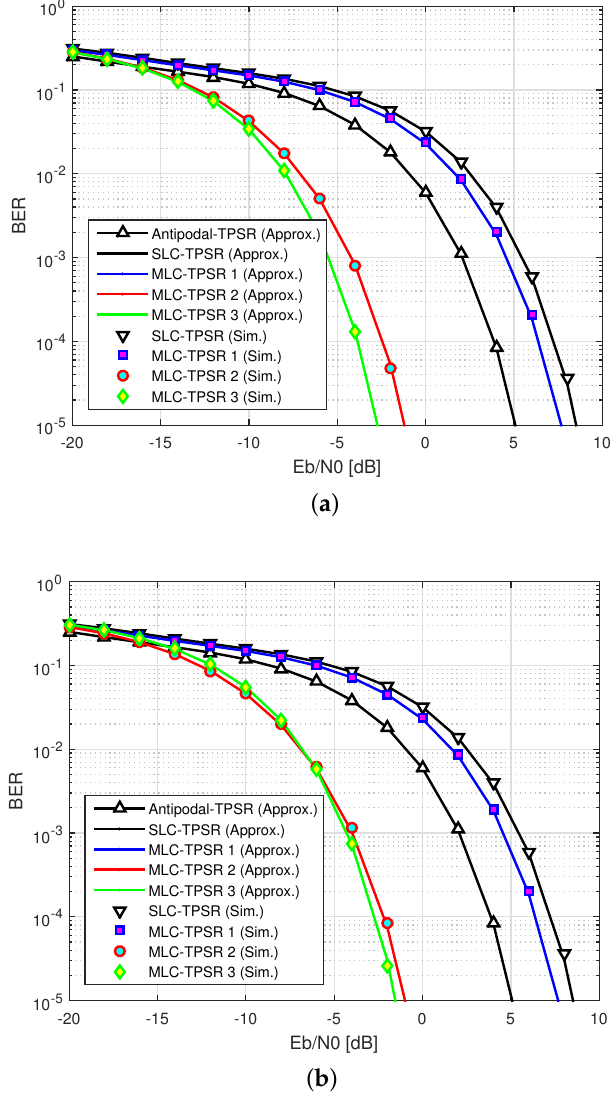
(cid:0) α = − 3 dB, G p = 30